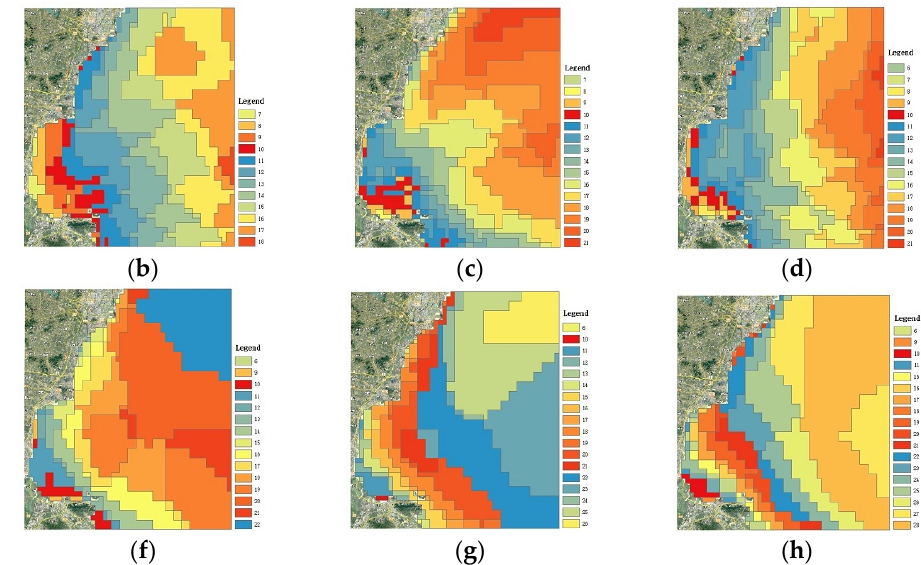
Figure 7. Irregular mesh based on a 24 h time series. ( a – h ) are 3 h moment, 6 h moment, 9 h moment, 12 h moment, 15 h moment, 18 h moment, 21 h moment, 24 h moment in the 24 h time series, re- spectively.